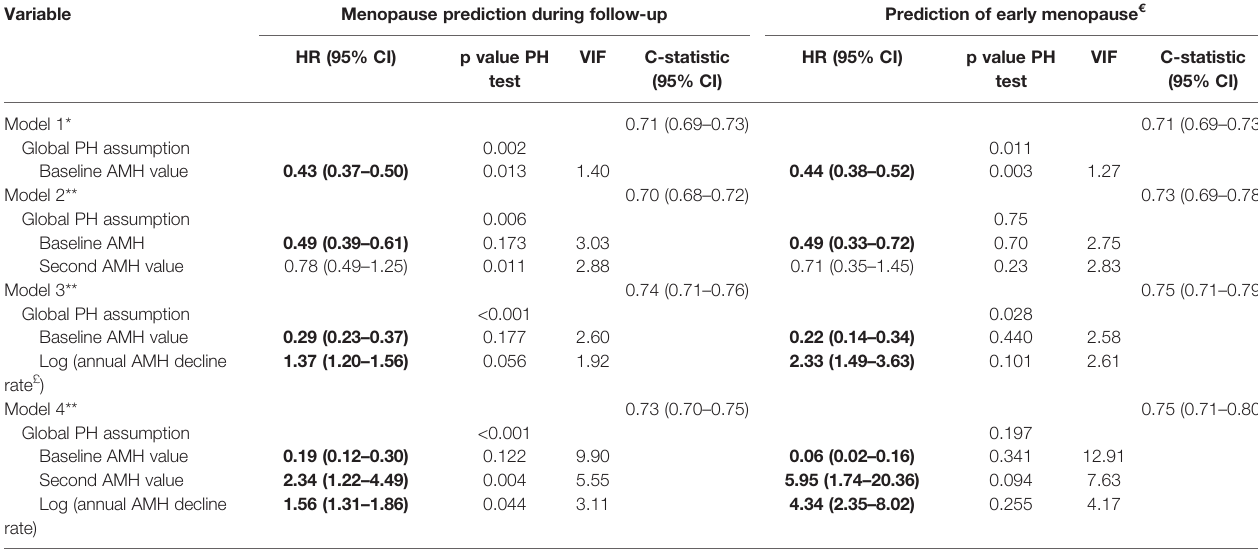
TABLE 2 | Summary of statistics for the proportional hazard Cox regression approach (include test of proportional hazards assumption) for prediction of menopause/ early menopause according to single/repeated AMH measurements. Variable Menopause prediction during